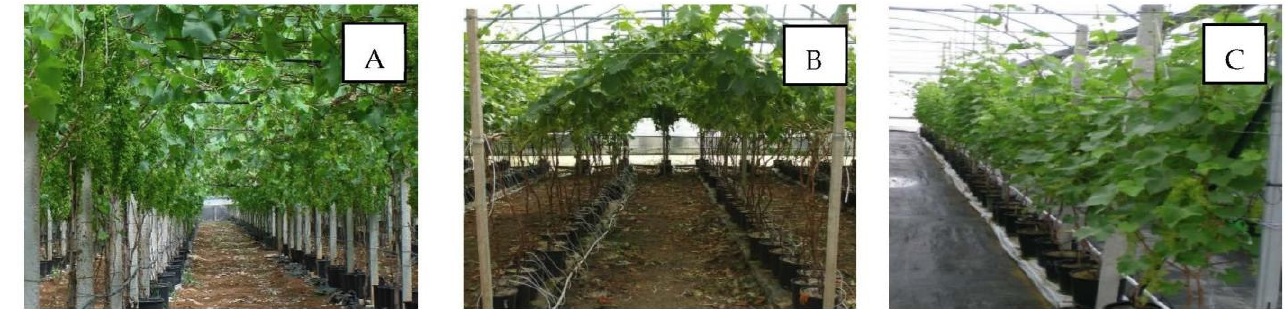
Figure 8. Trellis design generally adopted in TGSC: ( A ) pergola; ( B ) V (gable); ( C ) vertical trellis.